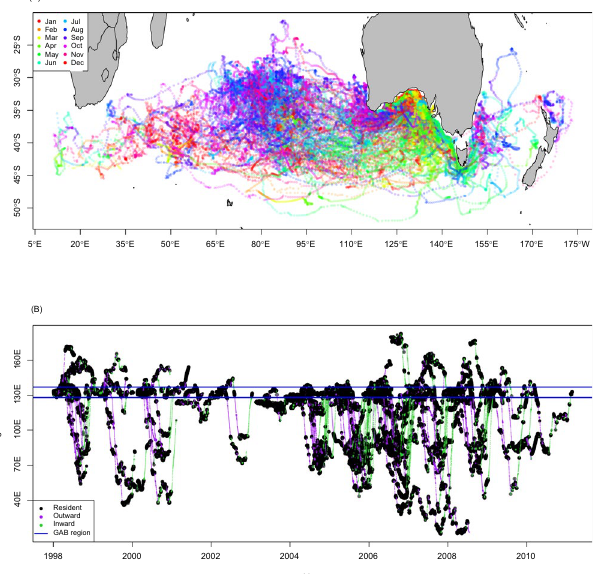
Figure 1. ( A ) Estimated movements of juvenile southern bluefin tuna (coloured by month) derived from deployments of archival tags 1998–2011. ( B ) East-west pattern of migrations of all juvenile southern bluefin tuna coloured according to the most likely movement state classification, with black identifying periods of residence, purple identifying migrations away from the Great Australian Bight (GAB) and green identifying migrations toward the